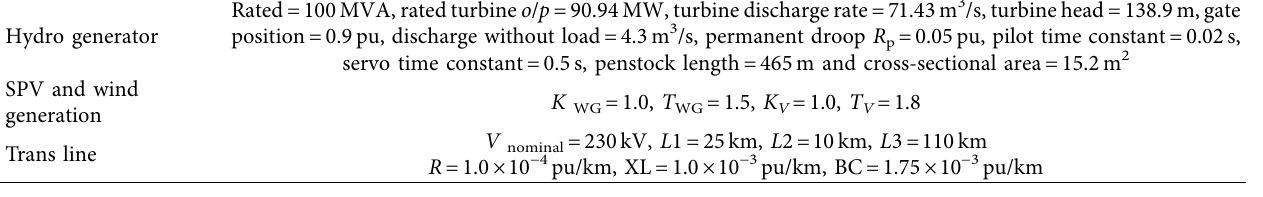
Table 2: System data.